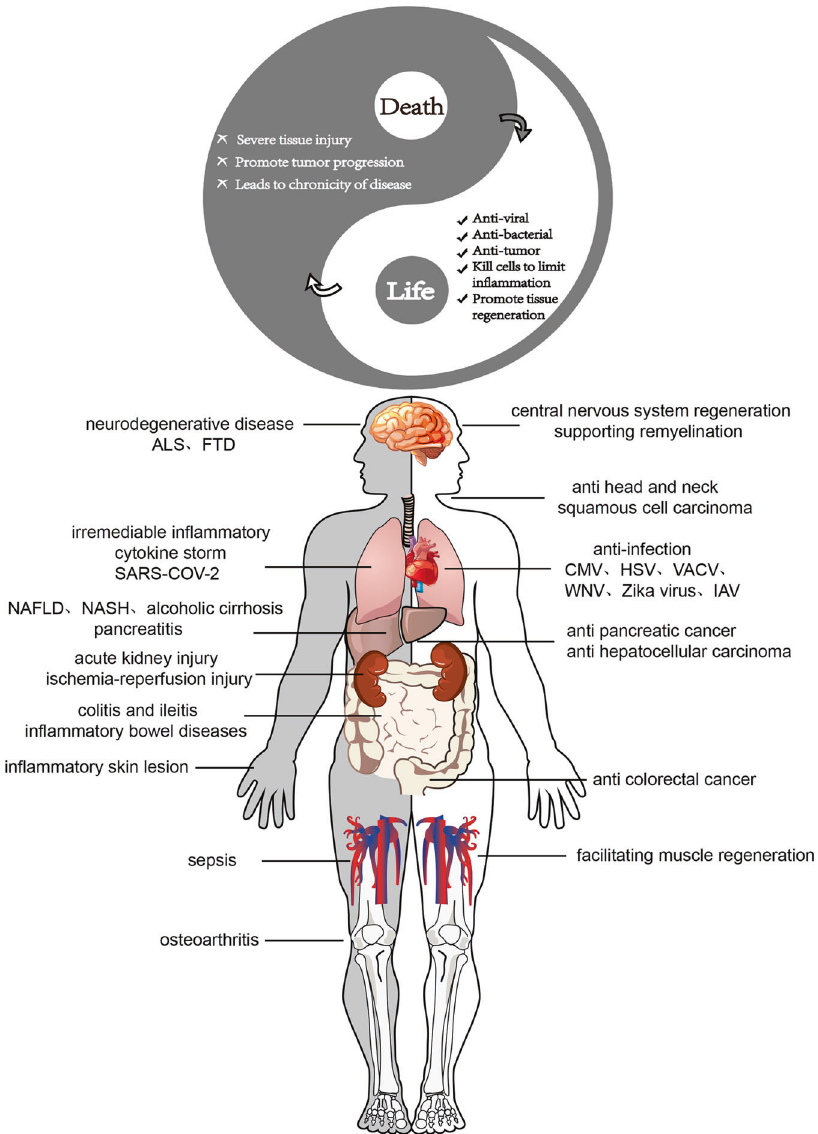
Fig. 3 The “ Tai Chi ” model of necroptosis in regulating life and death. The adverse effects caused by necroptosis can be turned into positive effects; similarly, an excess of positive effects can lead to death in the host cells. Therefore, controlling the balance between life and death represents a considerable